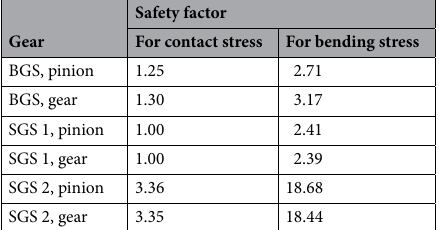
Table 4. Gear safety factors of maize harvester gearbox using